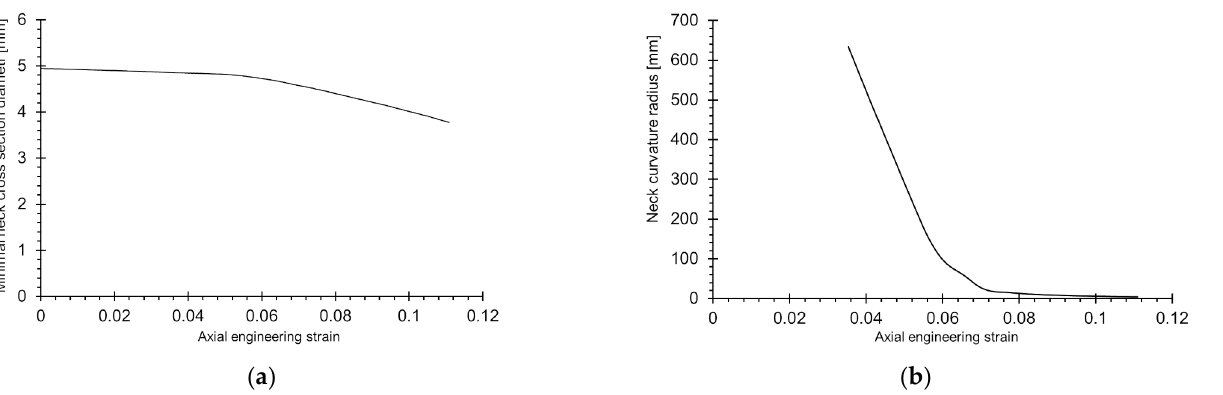
Figure 10. Changes in characteristic dimensions of neck during tensile test: ( a ) minimum neck cross-sectional diameter and ( b ) neck curvature radius.